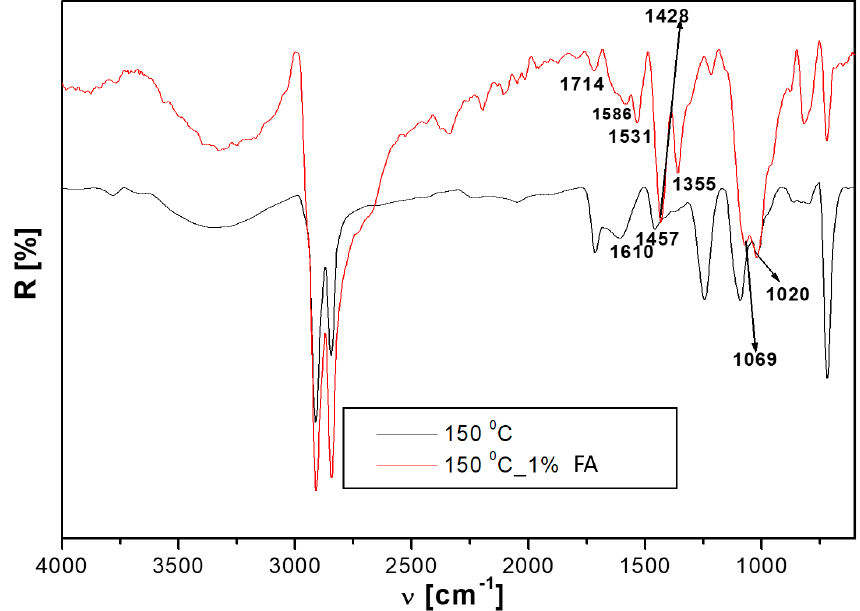
Figure 3. FTIR spectra of samples cured at150 °C with and without FA, coded as 1S_FA—2 and 1S.